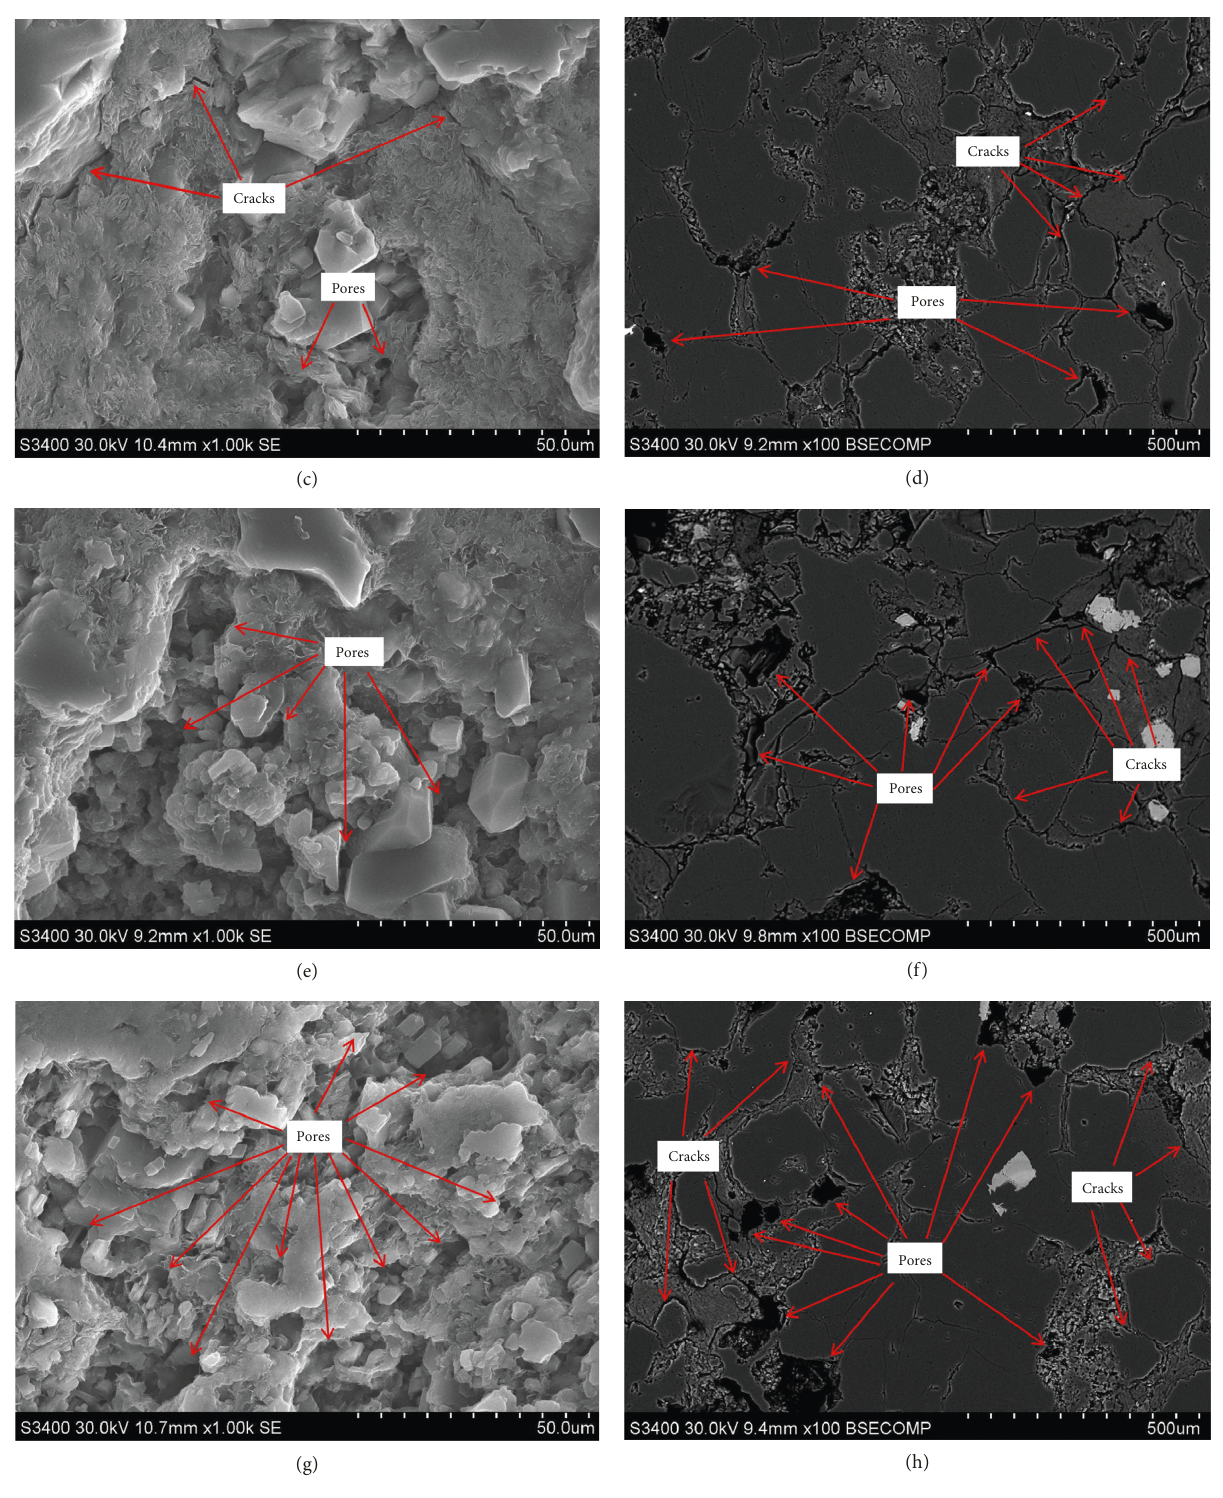
Figure 2: SEM and EDS observation of sandstone after H-C cycles: (a) 20 ° C (SEM 200 μ m and 50 μ m), (b) 20 ° C (EDS 100 μ m), (c) after 40 cycles in L-Tgroup (SEM 50 μ m), (d) after 40 cycles in L-Tgroup (EDS 500 μ m), (e) after 40 cycles in M-Tgroup (SEM 50 μ m), (f) after 40 cycles in M-T group (EDS 500 μ m), (g) after 12 cycles in H-T group (SEM 50 μ m), and (h) after 12 cycles in H-T group (EDS 500 μ